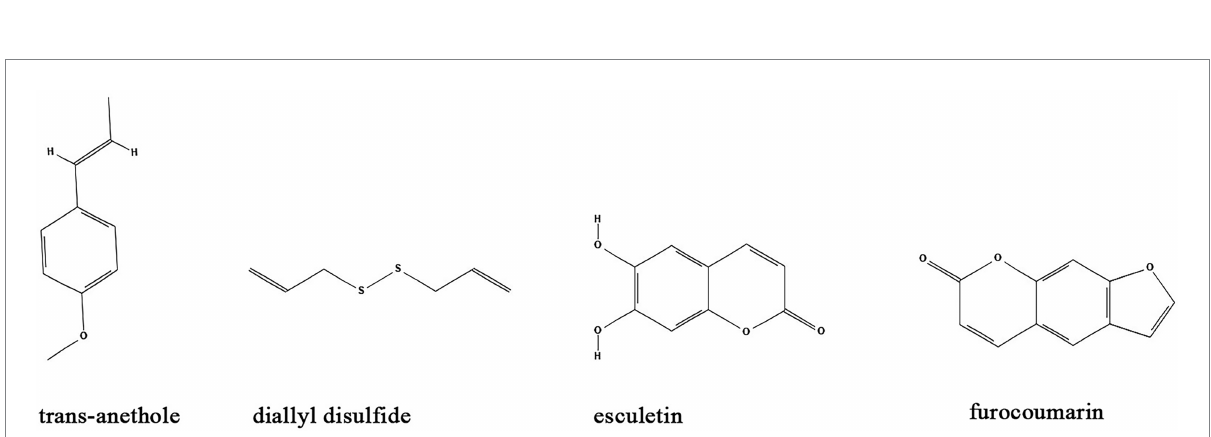
FIGURE 7 Chemical structures of other compounds that inhibit biofilm formation via QS. ChemDraw software has been utilized to draw the chemical structures of the